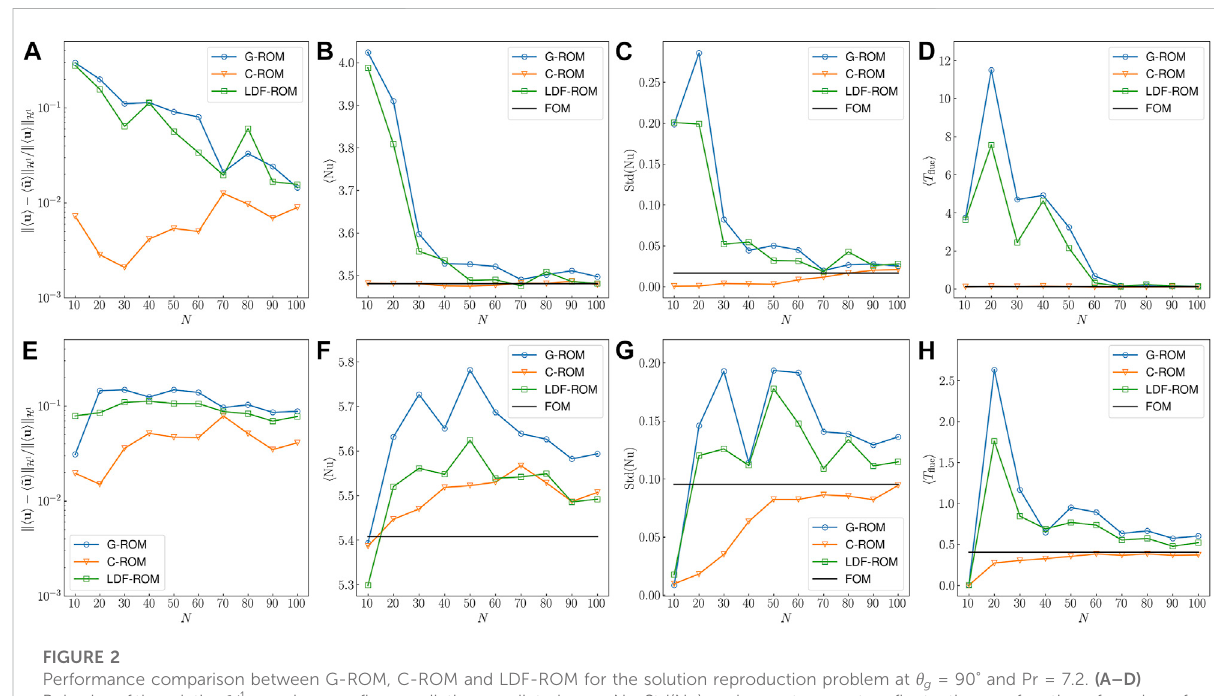
FIGURE 2 Performance comparison between G-ROM, C-ROM and LDF-ROM for the solution reproduction problem at θ g = 90 ° and Pr = 7.2. (A – D) Behavior ofthe relative H 1 error in mean fl ow prediction, predicted mean Nu, Std(Nu), and mean temperature fl uctuation as a function of number of modes, N at Ra = 2 × 10 5 ( δ = 0.015625 in LDF-ROM). (E – H) Performance for the same quantities at Ra = 7 × 10 5 ( δ = 0.03125 in